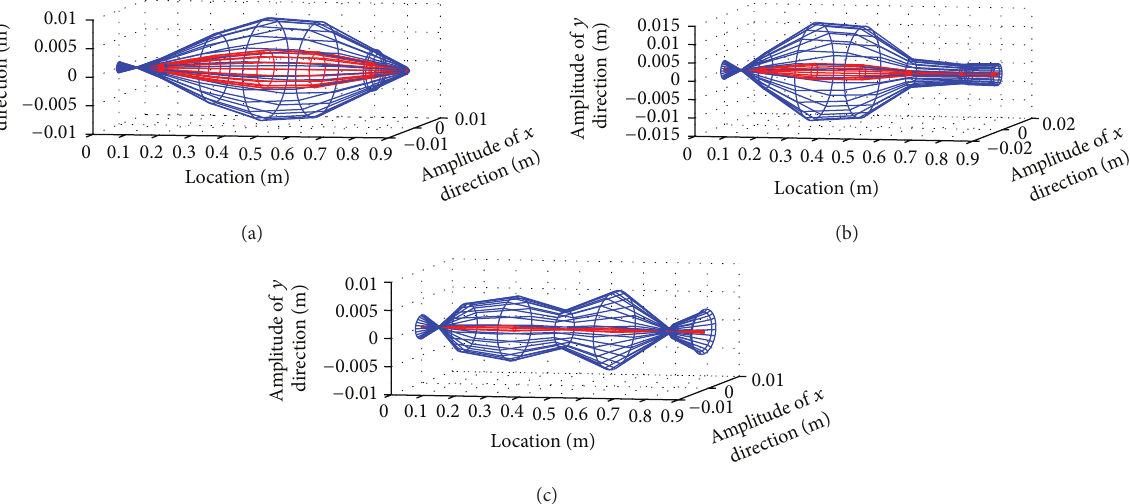
Figure 6: The lateral displacement response of the three-dimensional shape mode: without balancing (blue line) and with correction mass (red line); (a) the first critical speed of 800 rad/s; (b) the second critical speed of 1500rad/s; (c) the third critical speed of 2300